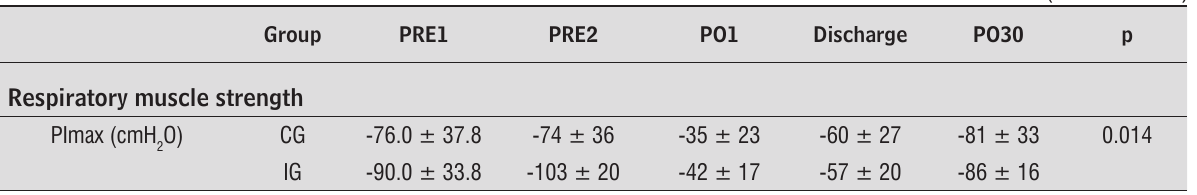
Table 2 - Respiratory muscle strength, pulmonary function and functional capacity of the control and intervention groups